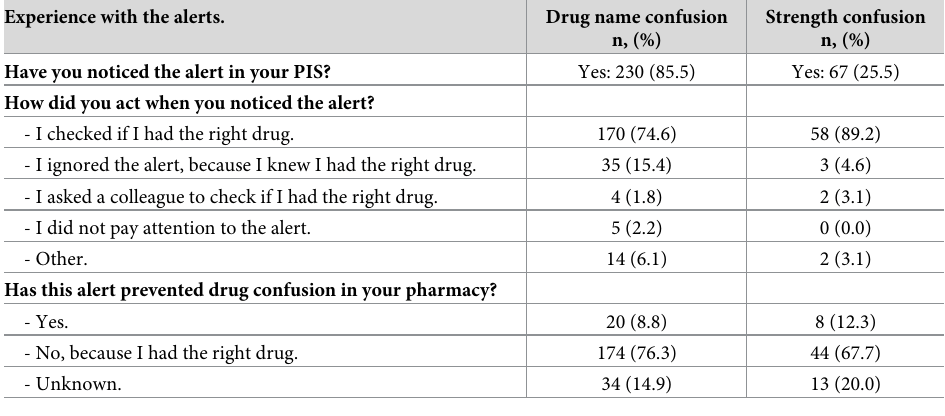
Abbreviations: PIS = pharmacy information